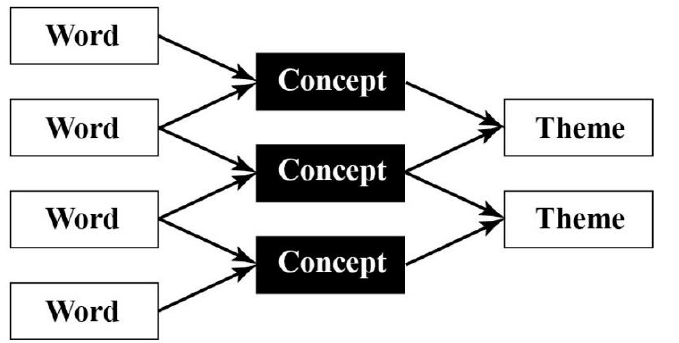
Figure 1. The extraction process of Leximancer analysis (Adopted from Crofts and Bisman